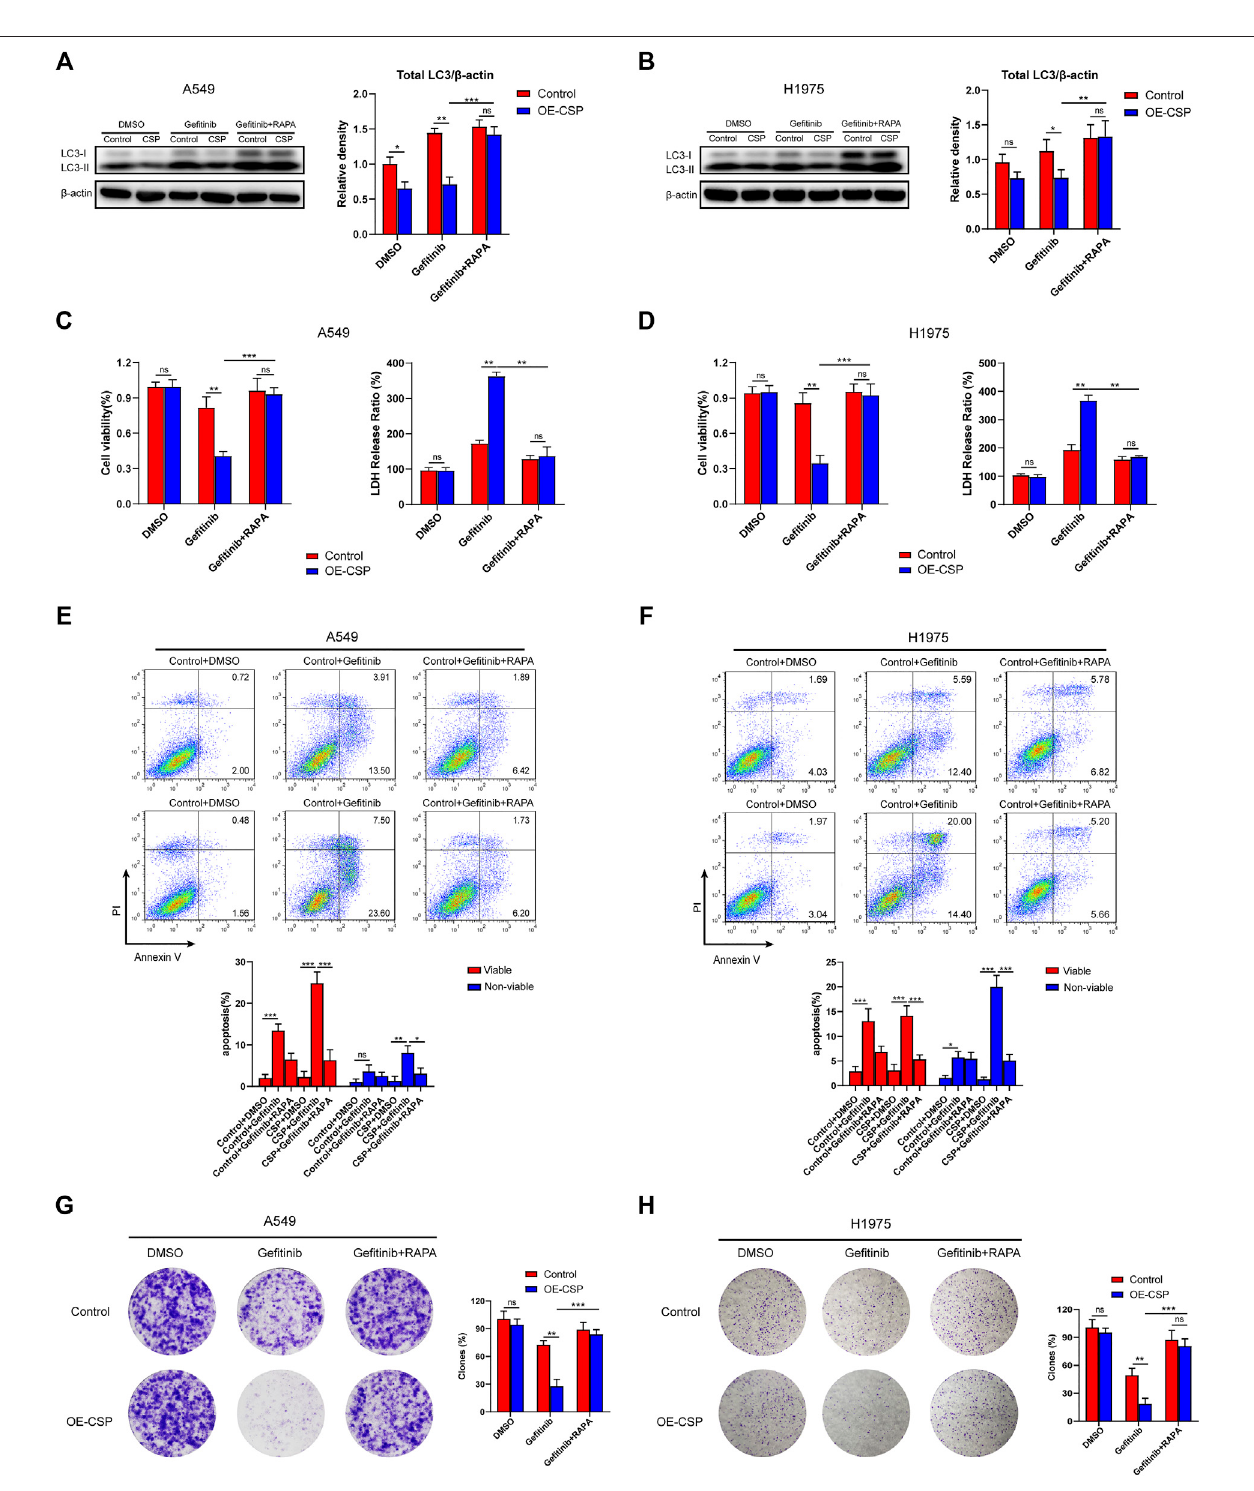
FIGURE5| Inhibitoryeffectofge fi tinibsensitizedbyCSPwasmediatedviasuppressionofautophagy.ControlandOE-CSPA549 (A) andH1975 (B) cells(1×10 6 ) wereseededin6-wellplatesandtreatedwithge fi tinibaloneorge fi tinibplusrapamycin.TheLC3BwasdetectedbyWesternblottingandrelativedensityoftotalLC3was analyzed.Representativeimages forwesternblotting( left )and statisticalhistograms( right ).Theviabilityof (C) A549and (D) H1975 cellswasexaminedusing aCCK8kit ( left ) and LDH assay ( right ). For apoptosis, 5 × 10 5 control and OE-CSP (E) A549 and (F) H1975 cells were treated with ge fi tinib alone or ge fi tinib plus rapamycin and stained with Annexin V and propidium iodide. The apoptosis rate was then detected using fl ow cytometry. Representative images for fl ow cytometry ( up ) and